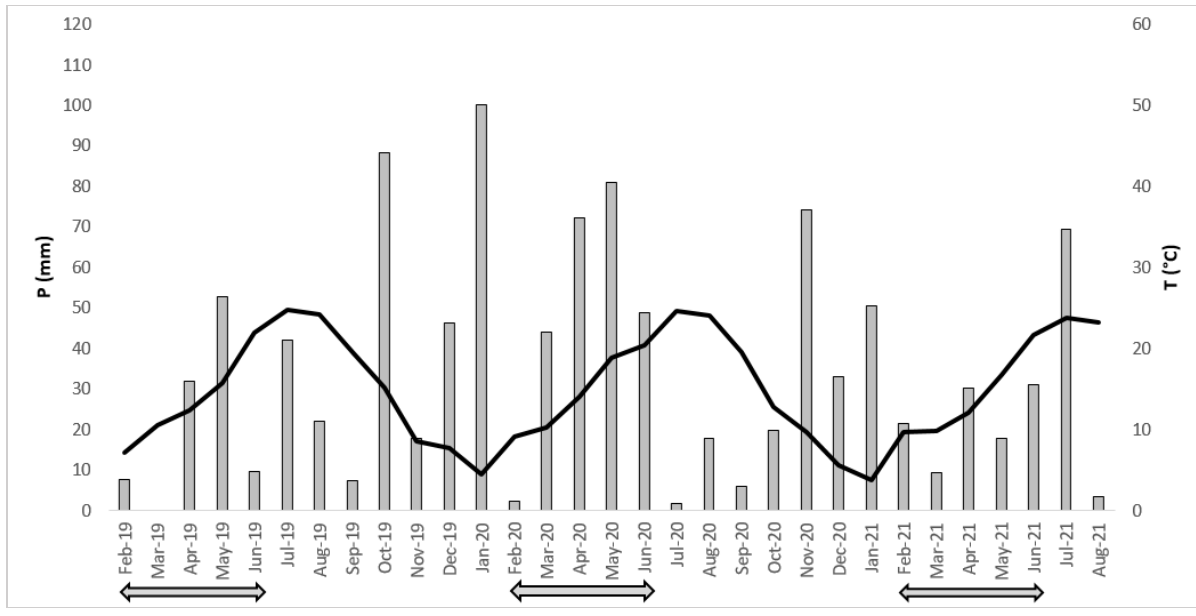
Figure 1. Weather conditions of the experiment period. Grey bars, total monthly precipitation (P); black line, mean monthly temperature (Tm). Arrows represent the growing season each year.